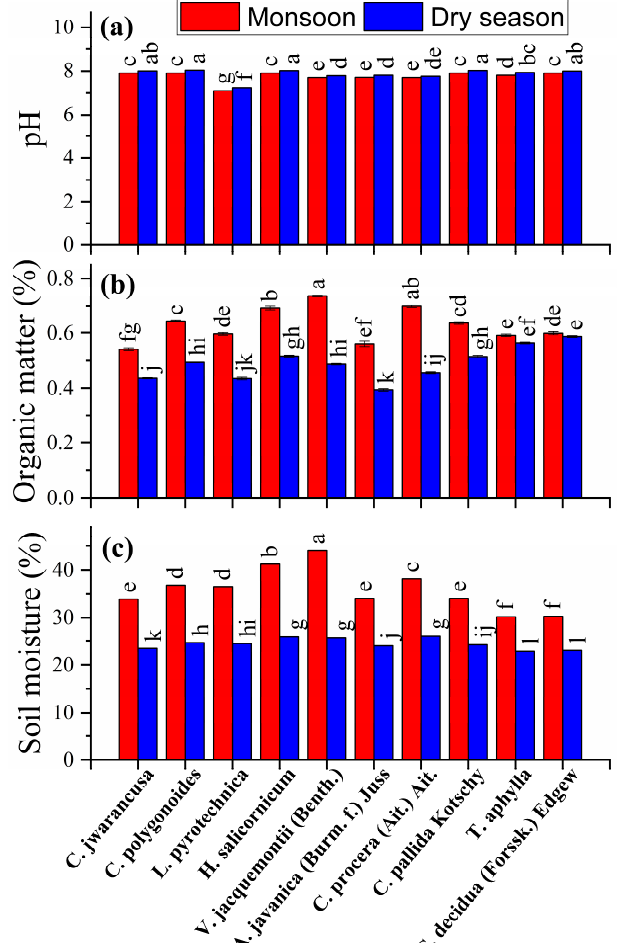
Figure 2. Soil chemical analysis: ( a ): soil pH; ( b ): soil organic matter; ( c ): soil moisture content. Different lowercase letter(s) indicate significant differences in the studied plant species according to the LSD test at p ≤ 0.05.